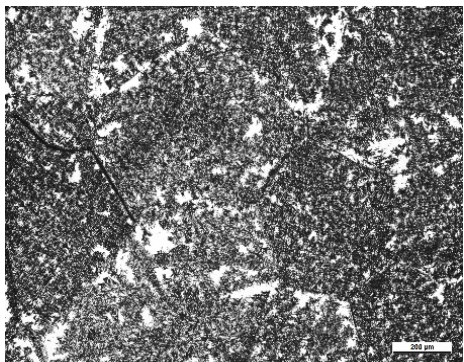
Figure 10. Microstructure of the specimen isothermally held at 600 °C for 60 min (solution temperature was 865 °C).